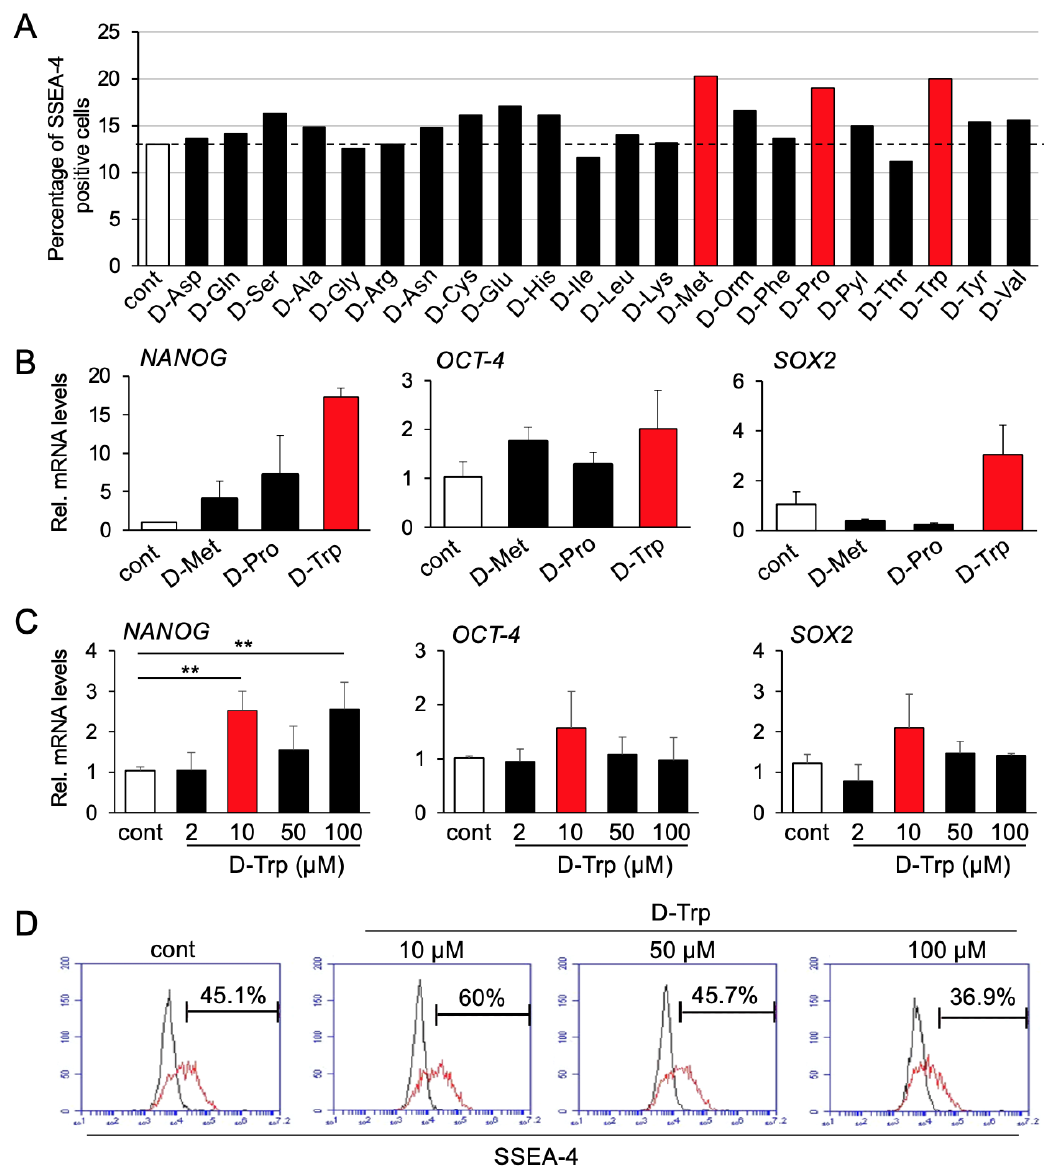
Figure 1. Screening process. ( A ) First screening by flow cytometry. Three candidate amino acids were selected (red columns): D-methionine (D-Met), D-proline (D-Pro), and D-tryptophan (D-Trp). The experiment was performed once. ( B ) Second screening by real-time RT-PCR. D-tryptophan (D-Trp) strongly enhanced the mRNA levels of stem cell markers, NANOG , OCT-4 , and SOX-2 . Results are representative of two independent experiments. ( C , D ) hBMSCs were